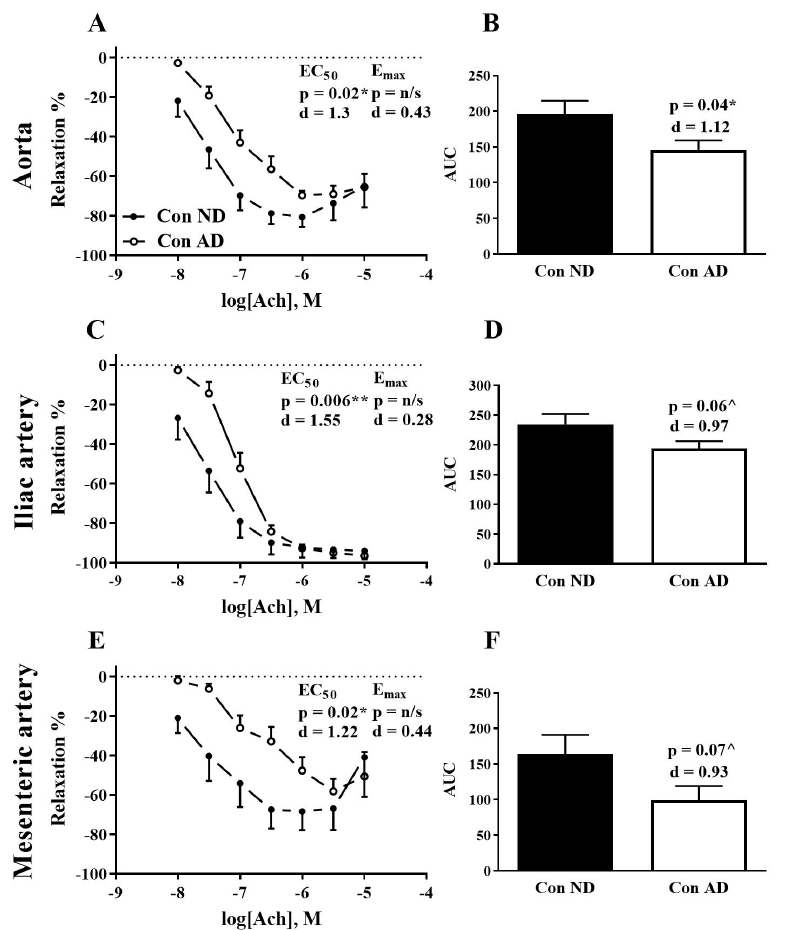
Figure 1. Ach-induced dose response curves in abdominal aorta ( A ), iliac artery ( C ), and mesenteric artery ( E ) incubated ex vivo for 2 h. Comparison between normal diet (closed circles) and atherogenic diet (open circles). Inset: EC 50 and E max statistical significance ( p ) and effect size ( d ) between diets. AUC in abdominal aorta ( B ), iliac artery ( D ), and mesenteric artery ( F ) presented as arbitrary values; numbers above columns represent the statistical significance ( p ) and effect size ( d ) between diets. n = 7–12 per group. All data mean ± SEM. * p < 0.05 ND vs. AD, ** p < 0.01 ND vs AD, ˆ p